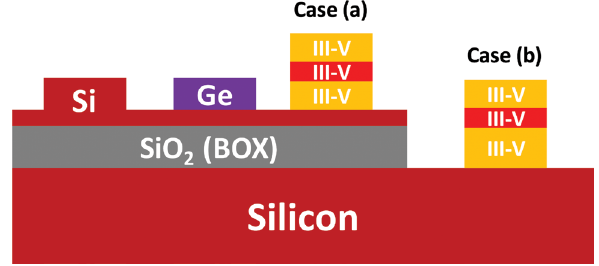
Figure 4 Simple schematic of the SOI waveguide platform, and how germanium and III–V compound semiconductor layers ought to typi- cally be integrated in order to achieve hybrid photodetectors and lasers, respectively, suggesting that in reality there exists no pure silicon or even group IV photonics, rather “groups III-to-V photon- ics” or “groups III-IV-V photonics” are semantically more accurate.